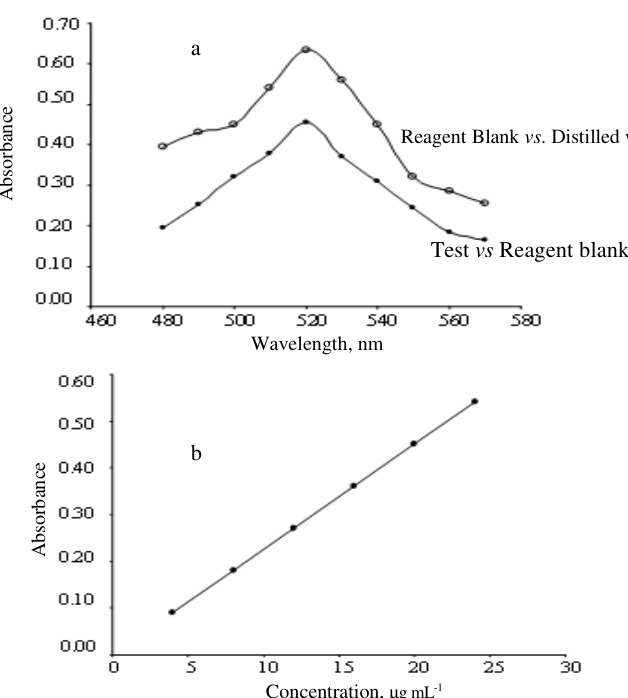
Figure 1. CEFT - NBS/PMAP – SA system; (a) Absorption spectrum (b) Beer’s law plot.